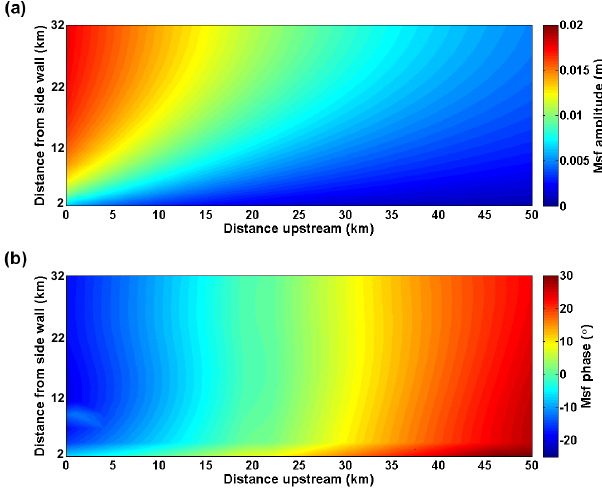
Figure 4. Comparison of change in grounding line position from the mean location, for various slopes ( γ ) as a function of time. The tidal forcing is also shown (solid black line), scaled up and shifted vertically.